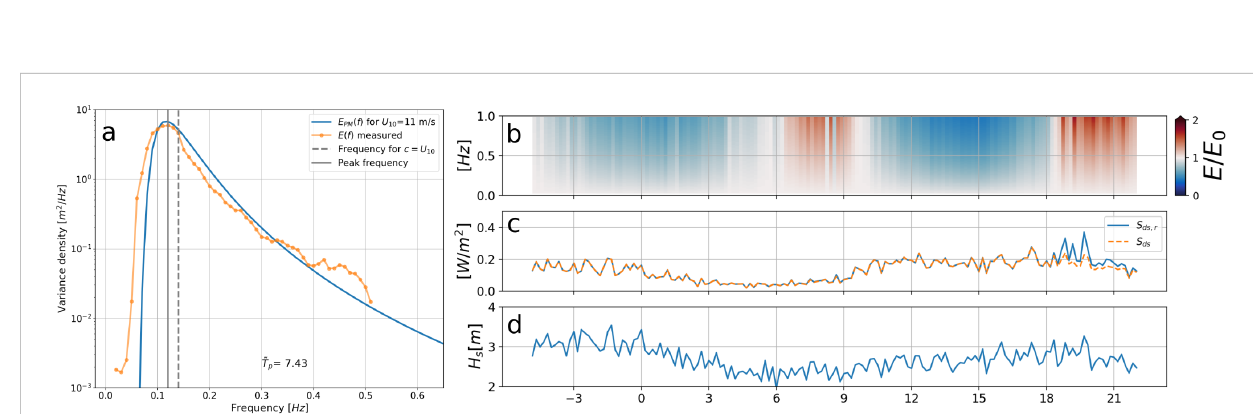
FIGURE A. 1 The impact of ambient currents on the wave fi eld. (A) show the measured wave variance density spectrum at the beginning of the time series together with a computed Pierson-Moskowitz spectrum. (B) show the time evolution of the initial Pierson-Moskowitz spectrum in (A) when exposed to the effective current in the wave propagation direction uwdir. (C) show TKE fl ux computed from the measured 1D variance spectrum according to Eq. (17) for Sds,r [Eq. (16)] and without the contribution from the ambient current [Fds, i.e. a3 = 0 in Eq. (16)]. (D) Time series of the measured signi fi cant wave height